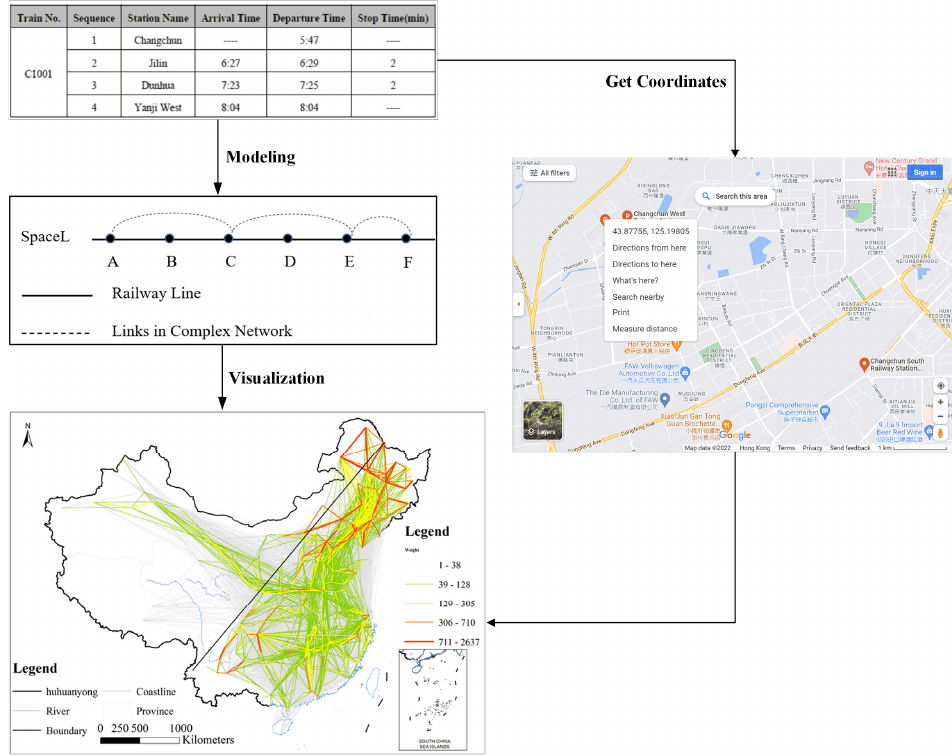
Figure 2. Geographical Railway Network Modeling.